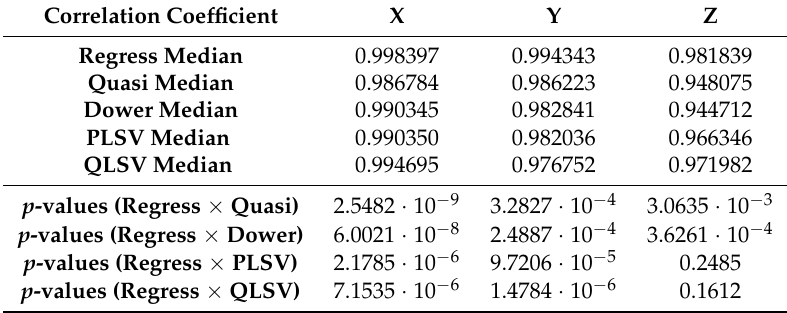
Table 6. Table of the medians of the R results for individual transformation methods and individual leads and the resulting p -valuess between the medians of Kors regression transformation and the medians of other transformation methods for the individual